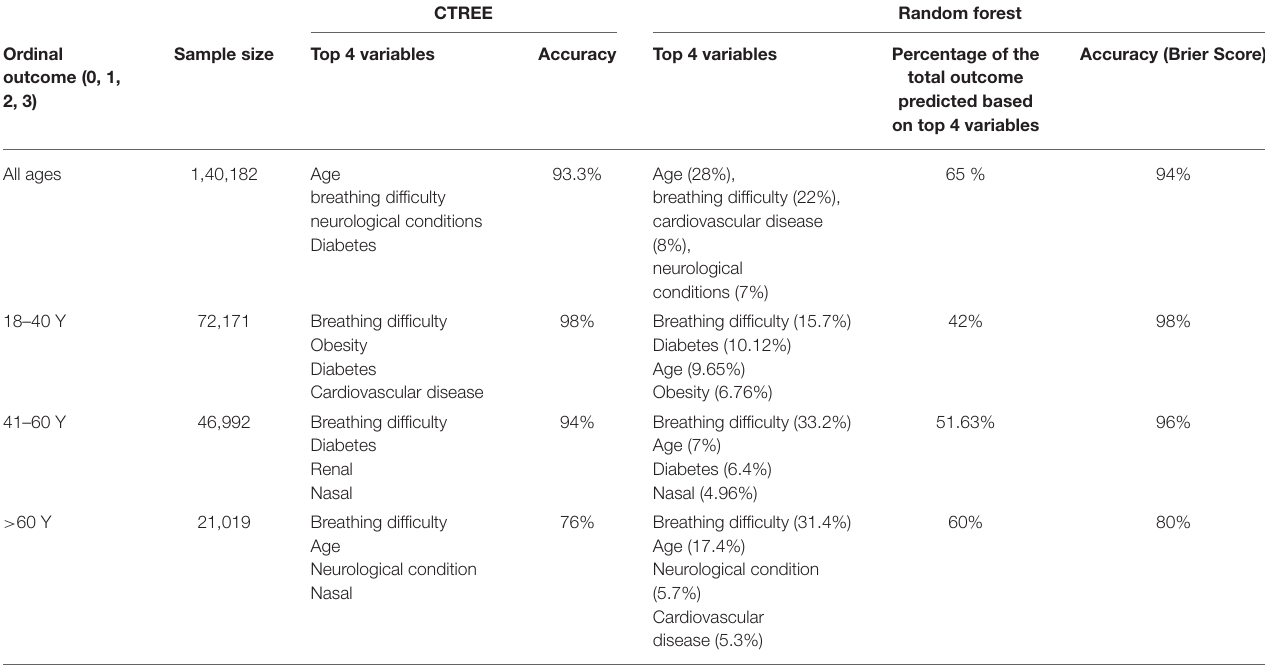
CTREE Random forest